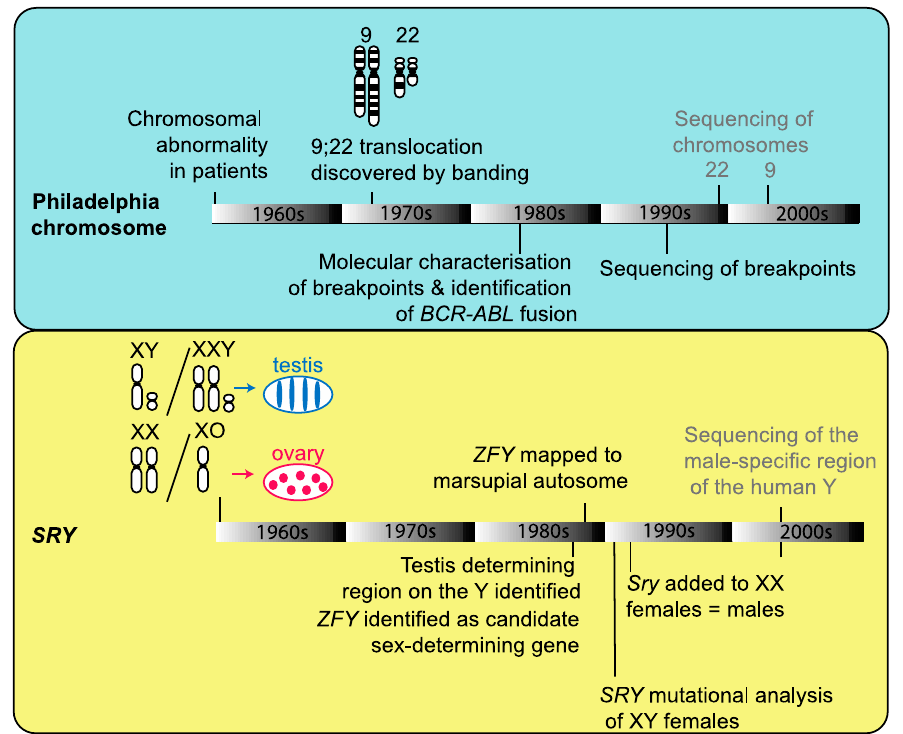
Figure 2. The incremental advances made through combined cytogenetic and genomic information in the discovery of the Philadelphia chromosome causing chronic myelogenous leukemia [29–33] and the discovery of the sex-determining gene SRY